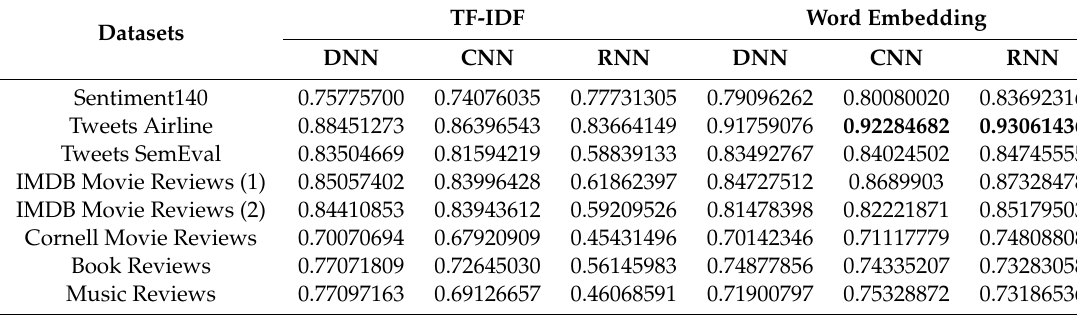
Table 4. The precision comparison for di ff erent datasets.